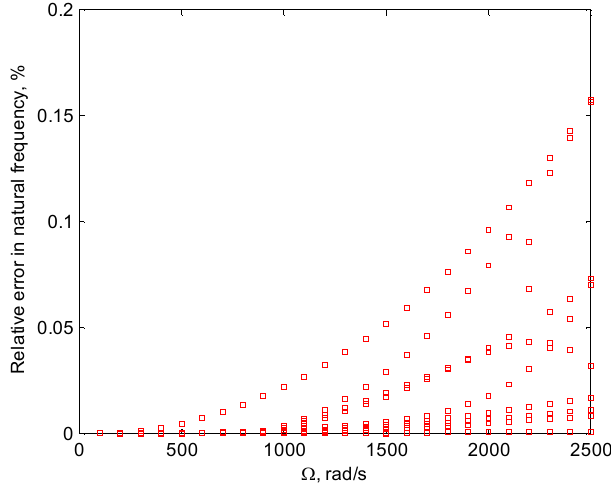
Figure 5. The relative errors in eigenvalues of the reduced-order model of a mistuned blade–disc–shaft assembly at different rotating speeds.